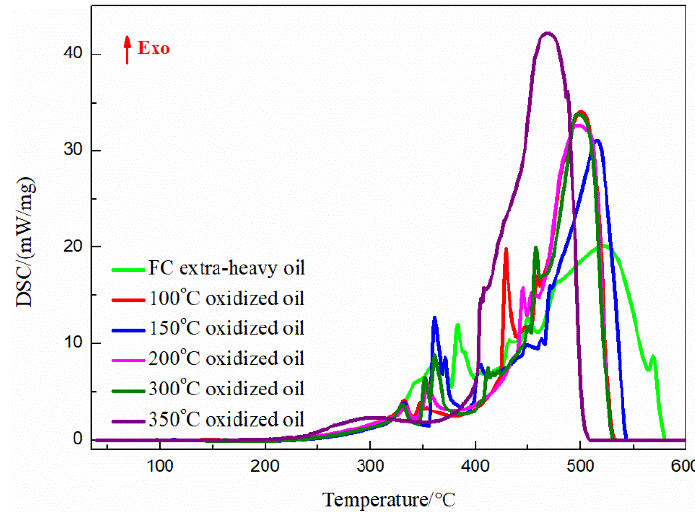
Figure 8. DSC curves of FC extra-heavy oil and oxidized oils at 10 ◦ C/min. Table 5. DSC parameters of FC extra-heavy oil and oxidized oils at 10 ◦ C/min.